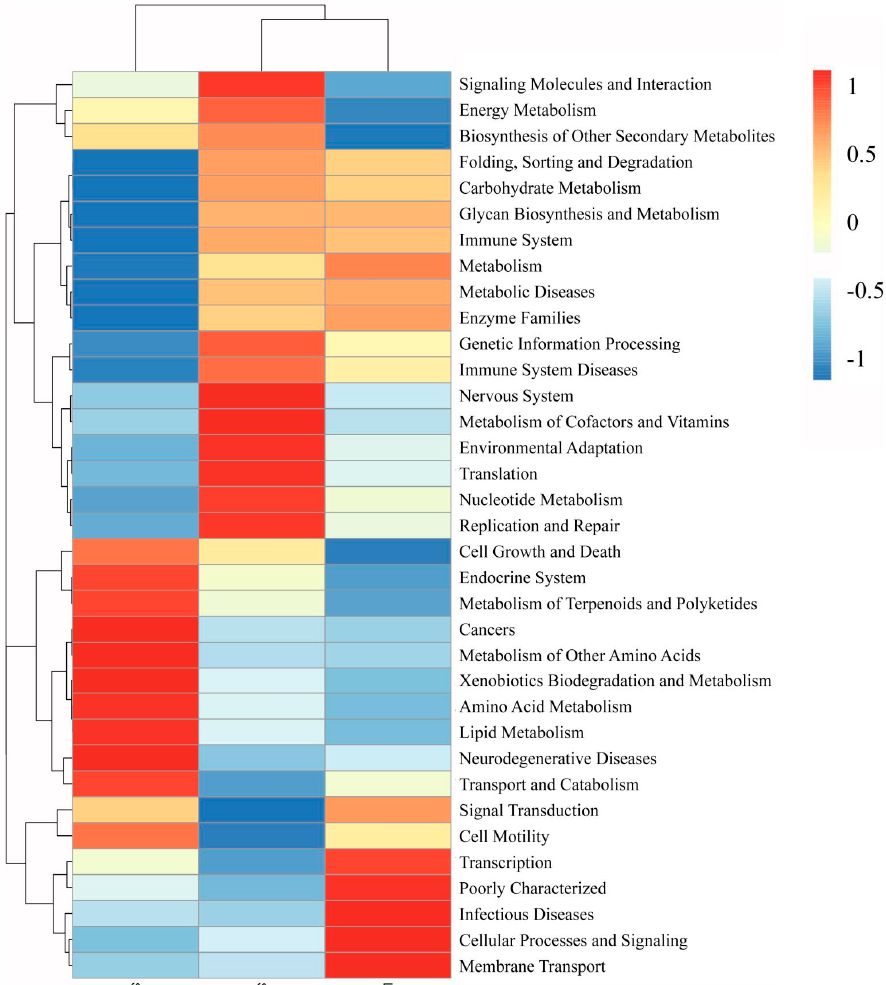
Figure 7. Heatmap of the hierarchy cluster results for the functional diversity of microbiota in the different segments of the gastrointestinal tract. Abbreviations: LI, large intestine; SI, small intestine; ST, stomach.